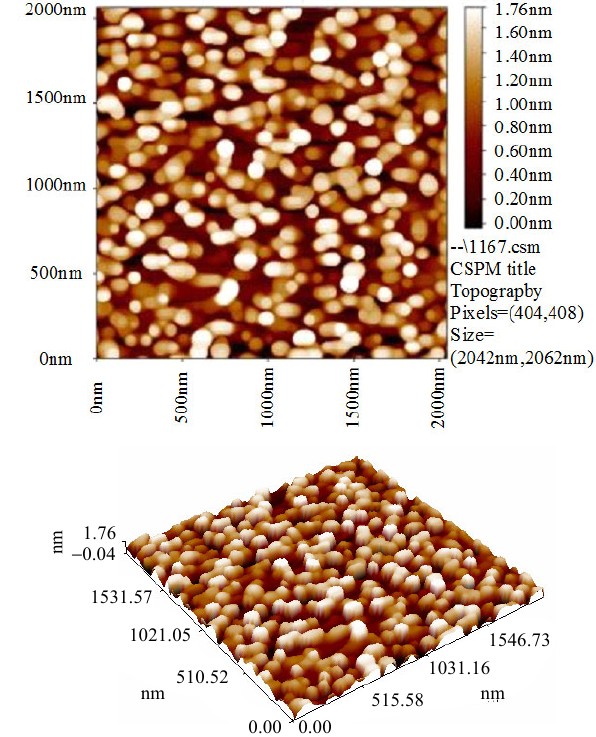
Fig. 6 2D and 3D AFM images for the nanostructured SiO 2 film prepared in this work.